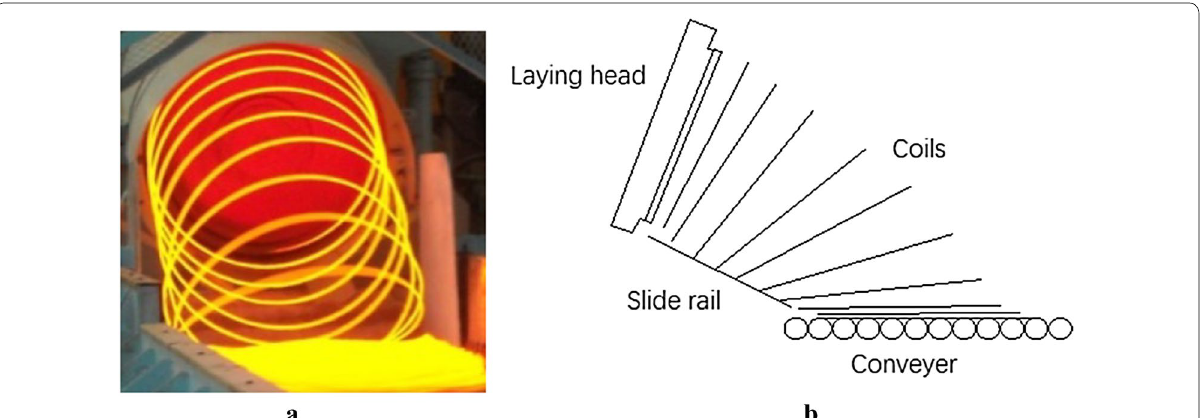
Figure 7 Appropriate coils dimension and motion at the exit of laying pipe: a regular coils dimension; b the ideal coils’ motion at the exit of laying pipe